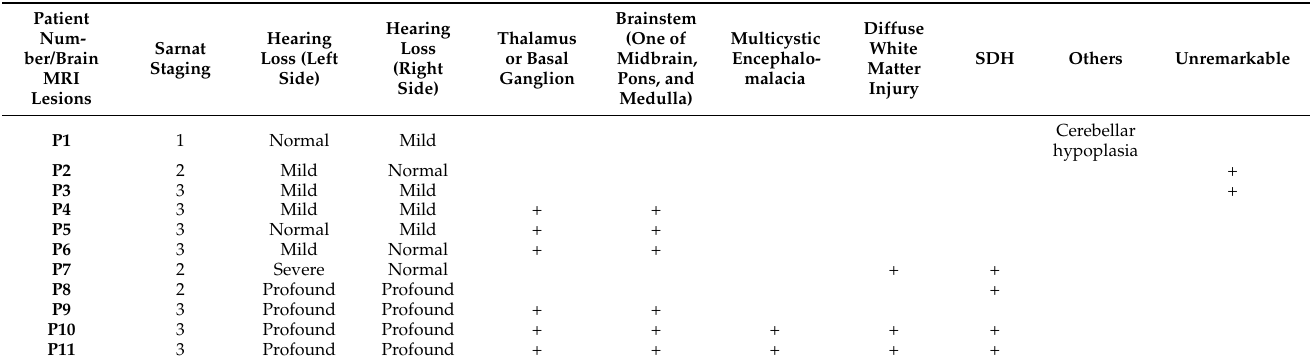
Table 4. Brain MRI results in patients with neonatal HIE with